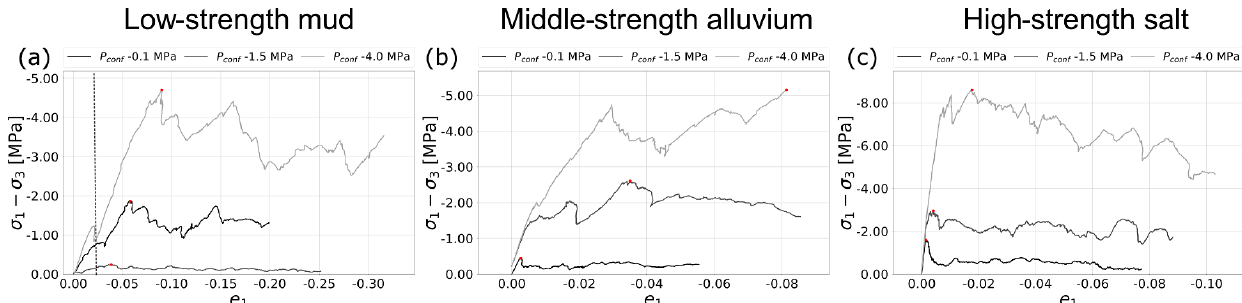
Figure 6. Differential stress vs. vertical strain plots for simulated compression tests. Confining pressures of − 0 . 1, − 1 . 5 and − 4 . 0MPa are compared that highlight the depth-dependent division into elastic, yielding and post-peak behaviour in all tested materials: (a) low-strength lacustrine mud, (b) middle-strength alluvial sediment and (c) high-strength Holocene salt material. Black dashed line in panel (a) marks the cutoff limit at E yy = − 0 . 02 for lacustrine mud elastic properties and peak stress